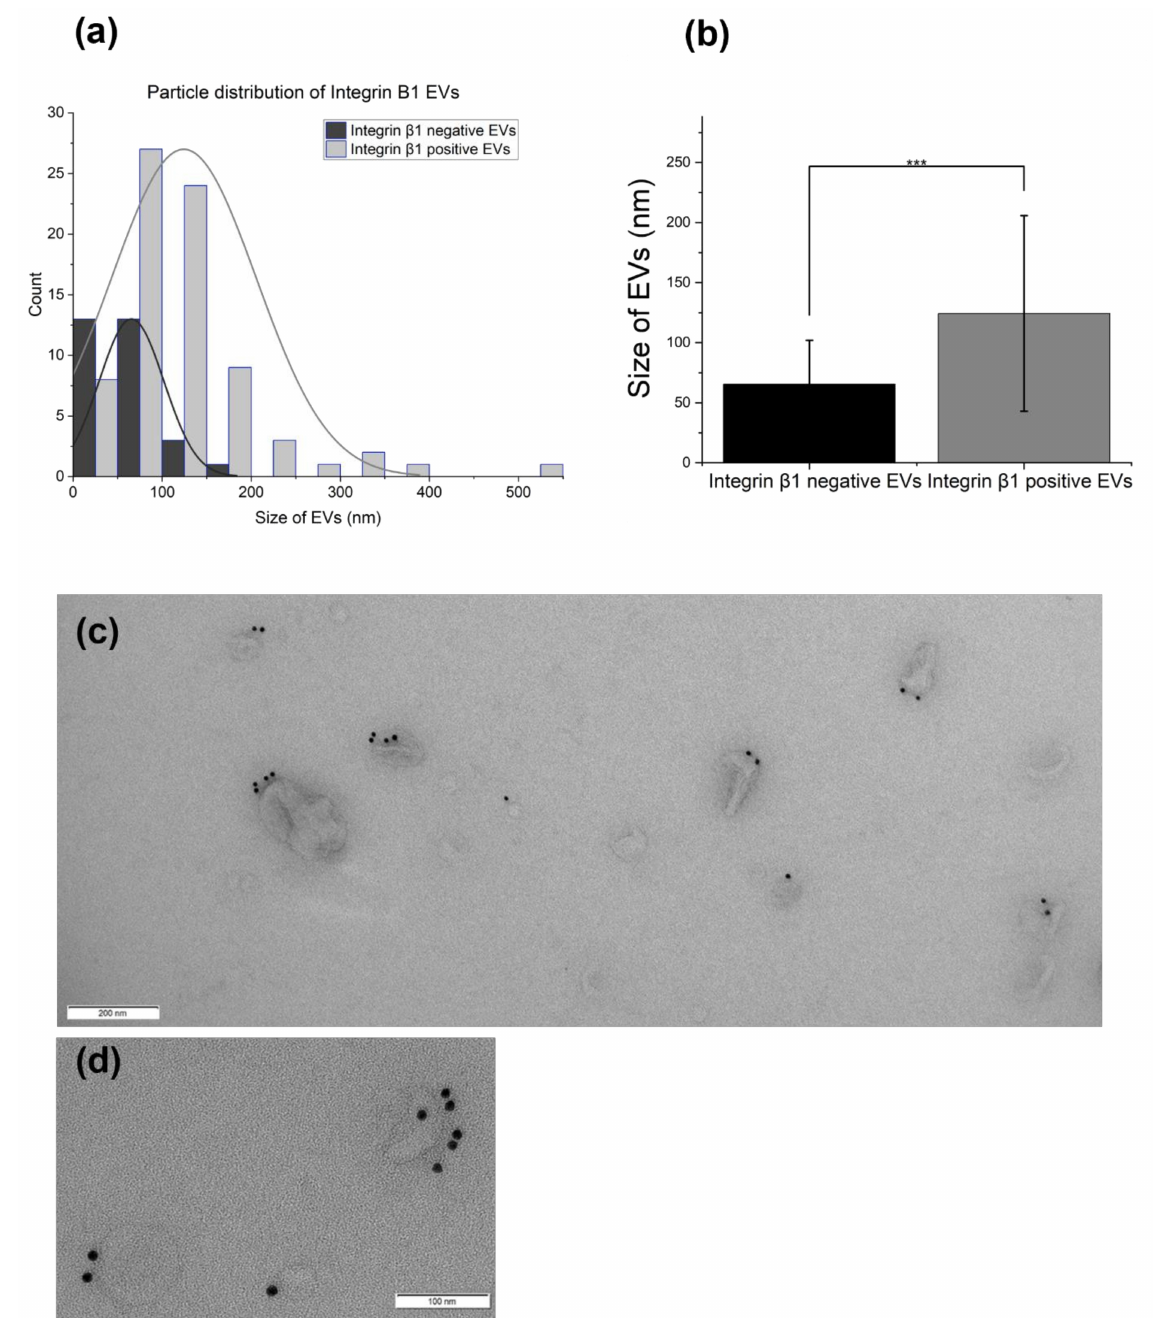
Figure 4. Integrin- β 1-positive EVs: ( a ) size distribution of the EVs taken from TEM images of astrocyte EVs stained with an anti-integrin β 1 antibody. Sizes measured with ImageJ. Graph generated by OriginPro 2022 (academic). ( b ) Graph indicating a significant difference in size between the integrin- β 1-positive EVs vs. the negative EVs using Tukey’s test for paired comparison of the means. ( c ) TEM image. ( d ) Higher magnification TEM